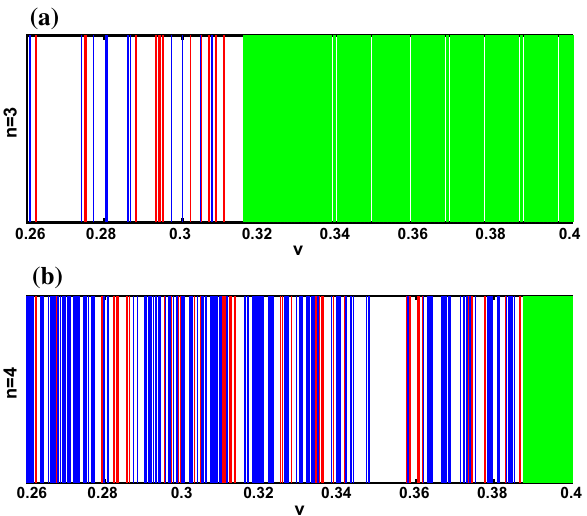
Fig. 9 Kink-antikink collisions: bion state (white), two oscillations (red), three oscillations (blue) and the K ¯ K escapes to the other vacuum (green) for a n = 3 and b n = 4